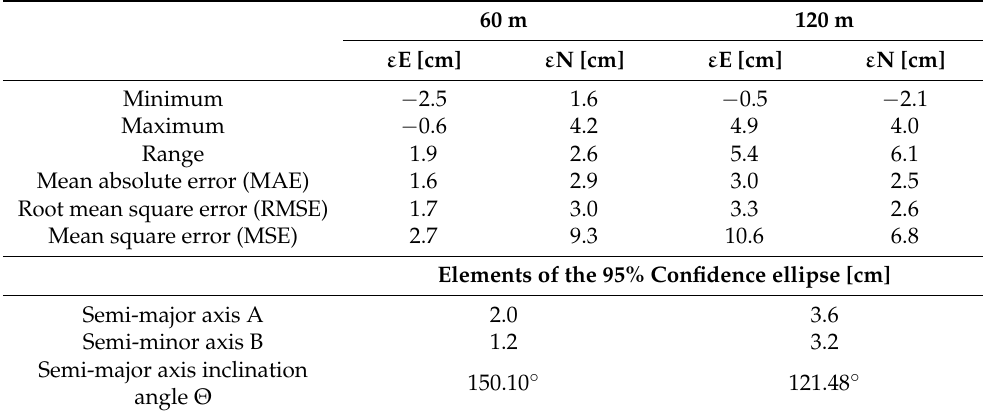
Table 8. UAS eBee—achieved data quality without the use of GCP